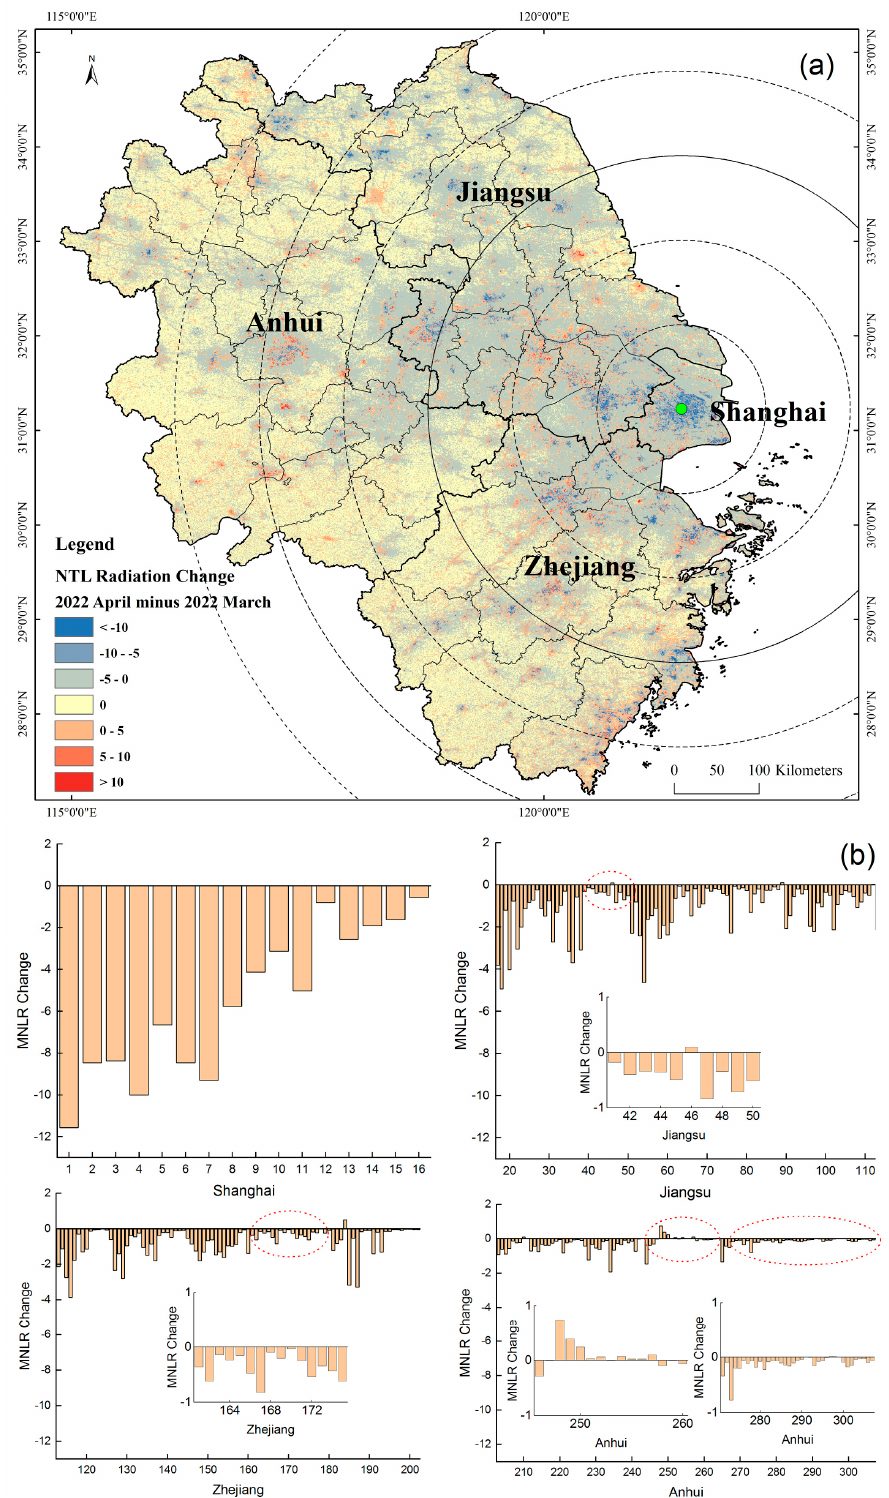
Figure 2. Spatio-temporal variation of MNLR from March to April 2022: ( a ) spatio-temporal variation of MNLR in the Yangtze River Delta; ( b ) MNLR changes of 307 counties in the Yangtze River Delta (Shanghai, Jiangsu, Zhejiang and Anhui). The serial number of the horizontal axis is arranged according to the county code. The red dashed box shows the portion with smaller values, which we have